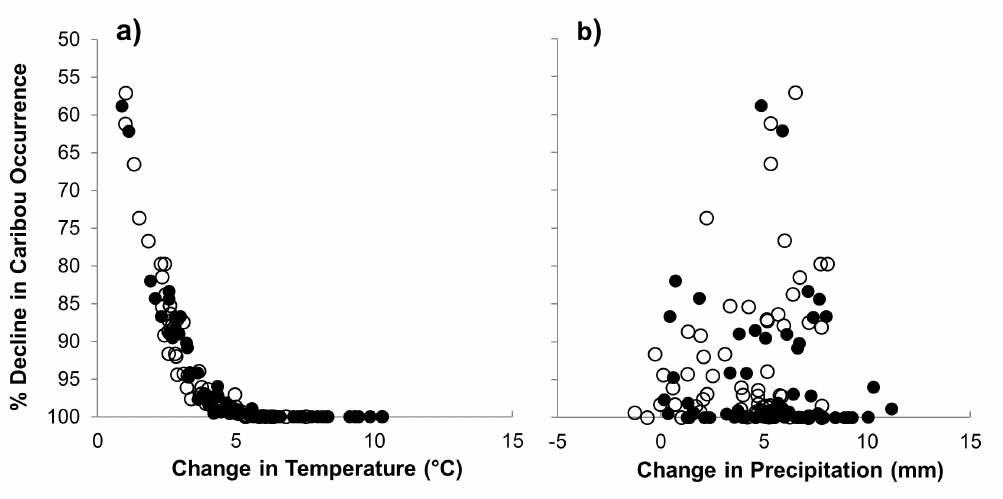
Figure 4. The percent reduction in the range extent of caribou with forecasted changes in minimum winter temperatures (a) and annual precipitation (b) for all 2050 (open circles) and 2070 (closed circles) climate change scenarios. Each point represents an average percent of caribou reduction across all grid cells in Ontario for one General Circulation Model